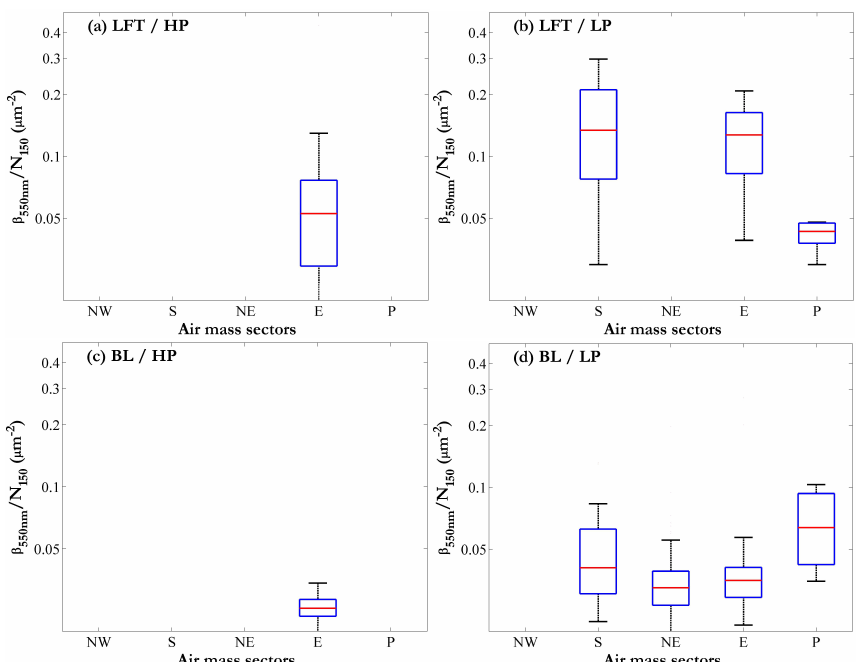
Fig. 8. Scattering cross section calculated at 550 nm wavelength for particles larger than 150 nm as a function of the air mass origin (NW: north-west Europe; S: south Europe; NE: north Europe; E: east Europe; P: polar) in the lower free troposphere (LFT) during anticyclonic (HP, a ) and cyclonic (LP, b ) conditions as well as in the boundary layer (BL) during anticyclonic (HP, c ) and cyclonic (LP, d ) conditions. Lower and upper limits of the box correspond to 25% and 75% percentiles, bottom and top whiskers the 5% and 95%. Middle bars indicate the